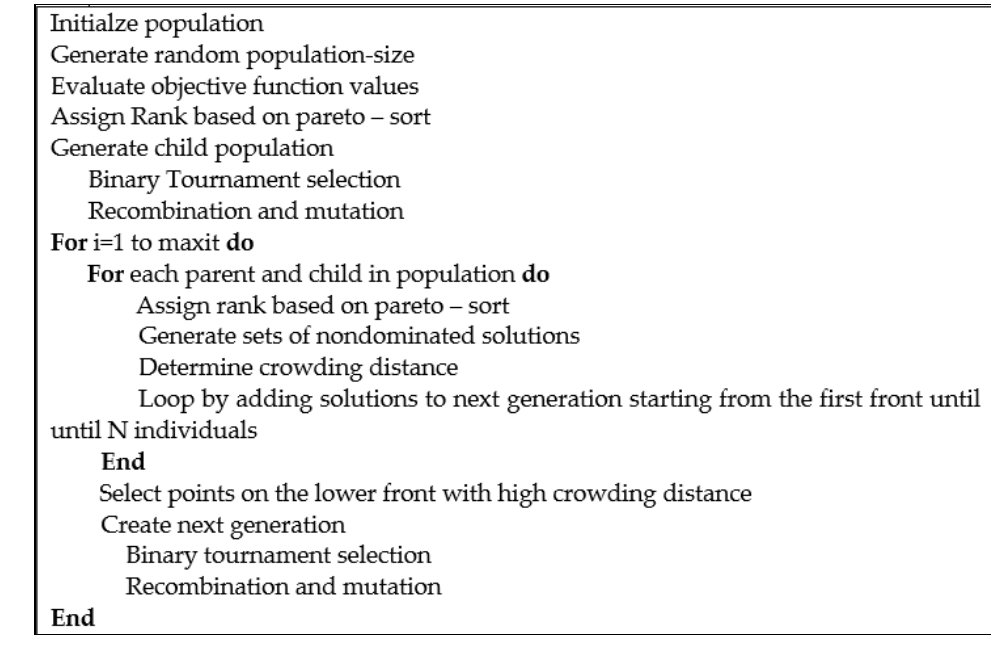
Figure 3. Pseudocode of NSGA II.